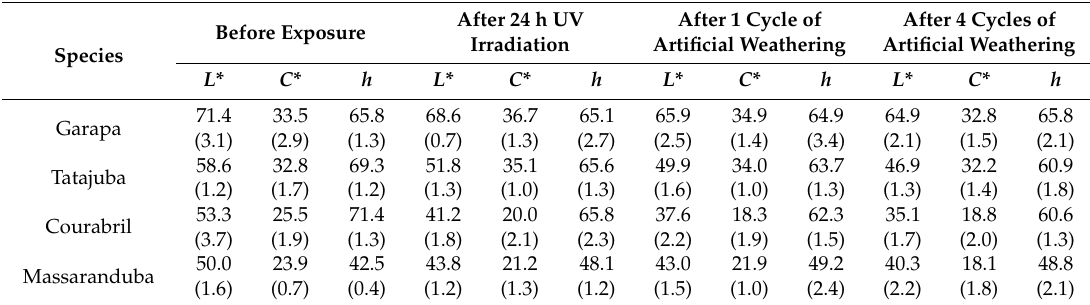
Table 3. Coordinates of CIE L*C*h colour system for individual woods (means and standard deviations in